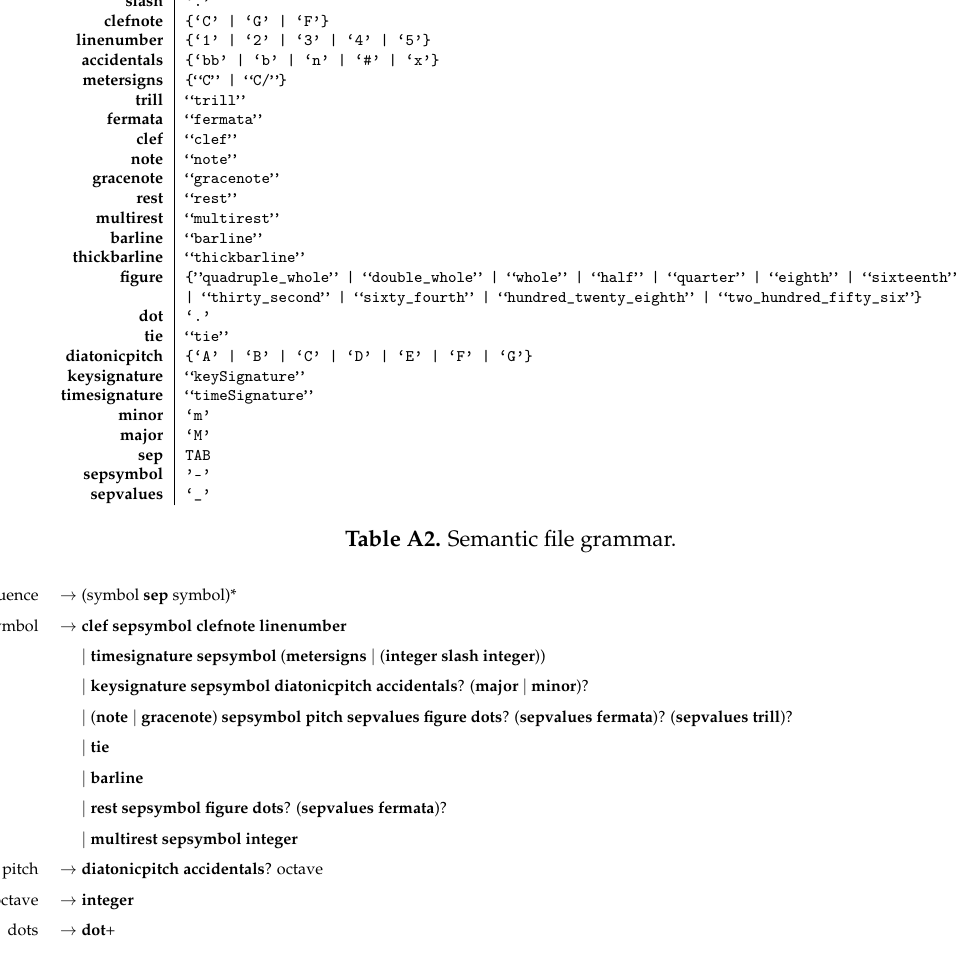
Table A1. Lexical rules for the semantic grammar.